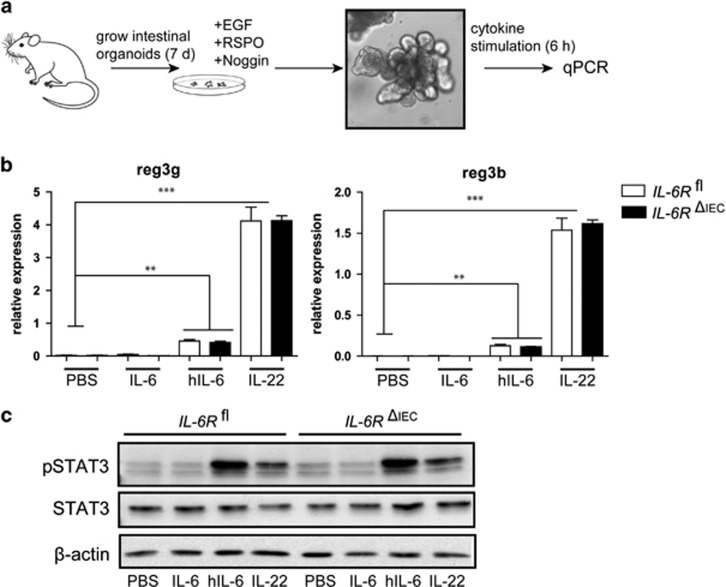
IL-6 trans-signalling, but not classic signalling, induces STAT3 target gene expression in intestinal organoids. (a) Mouse intestinal organoids from IL-6Rfland IL-6RΔIEC mice were cultivated as described previously.21 The medium was changed every other day and organoids were stimulated after 7 days of cultivation with hIL-6 (100 ng/ml), IL-6 (100 ng/ml) or IL-22 (100 ng/ml). (b) Expression of Reg3b and Reg3 was assessed by qPCR, and data are expressed as the expression relative to the housekeeping gene β-actin. (c) Western blot of isolated IECs, stimulated for 30 min with hIL-6 (100 ng/ml), IL-6 (100 ng/ml) or IL-22 (100 ng/ml) and probed for pSTAT3, STAT3 and β-actin. Data are representative of n=2 individual experiments. Significance was determined using the two-tailed Student's t-test, and data are expressed as mean ± s.d. **P<0.01; ***P<0.001.